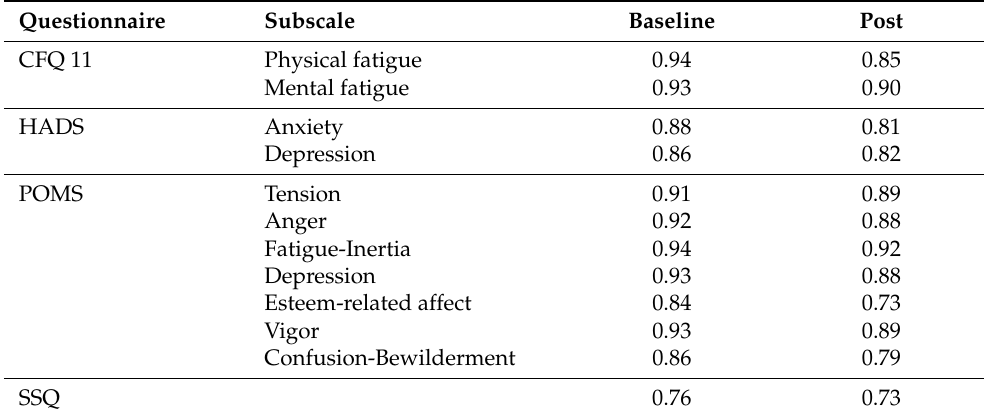
Table 3. Cronbach’s alpha for the different self-administered questionnaires at both evaluation times (baseline, post).